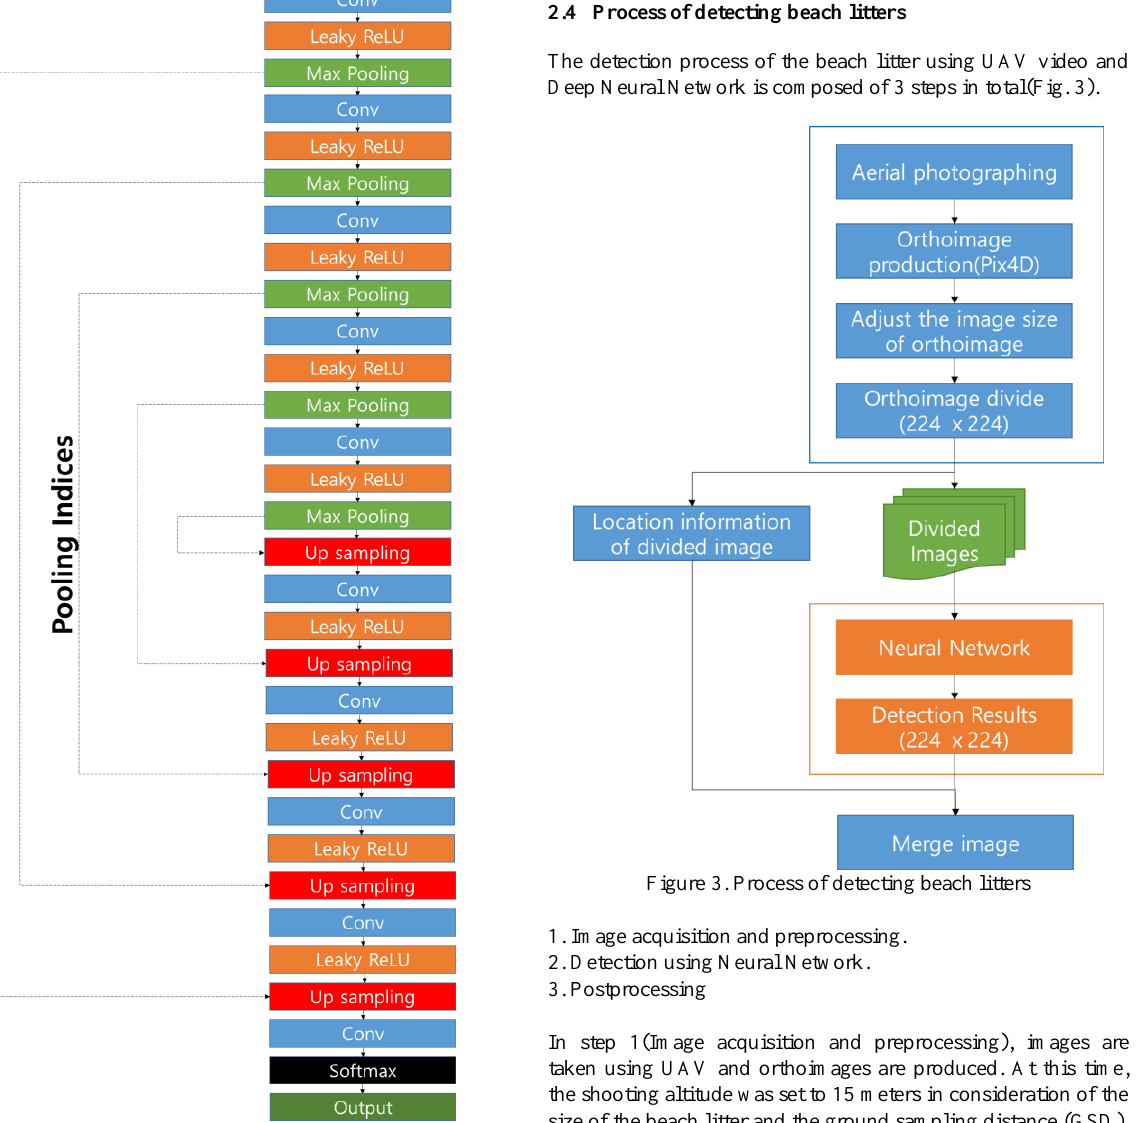
Figure 2. Structure of Neural Network